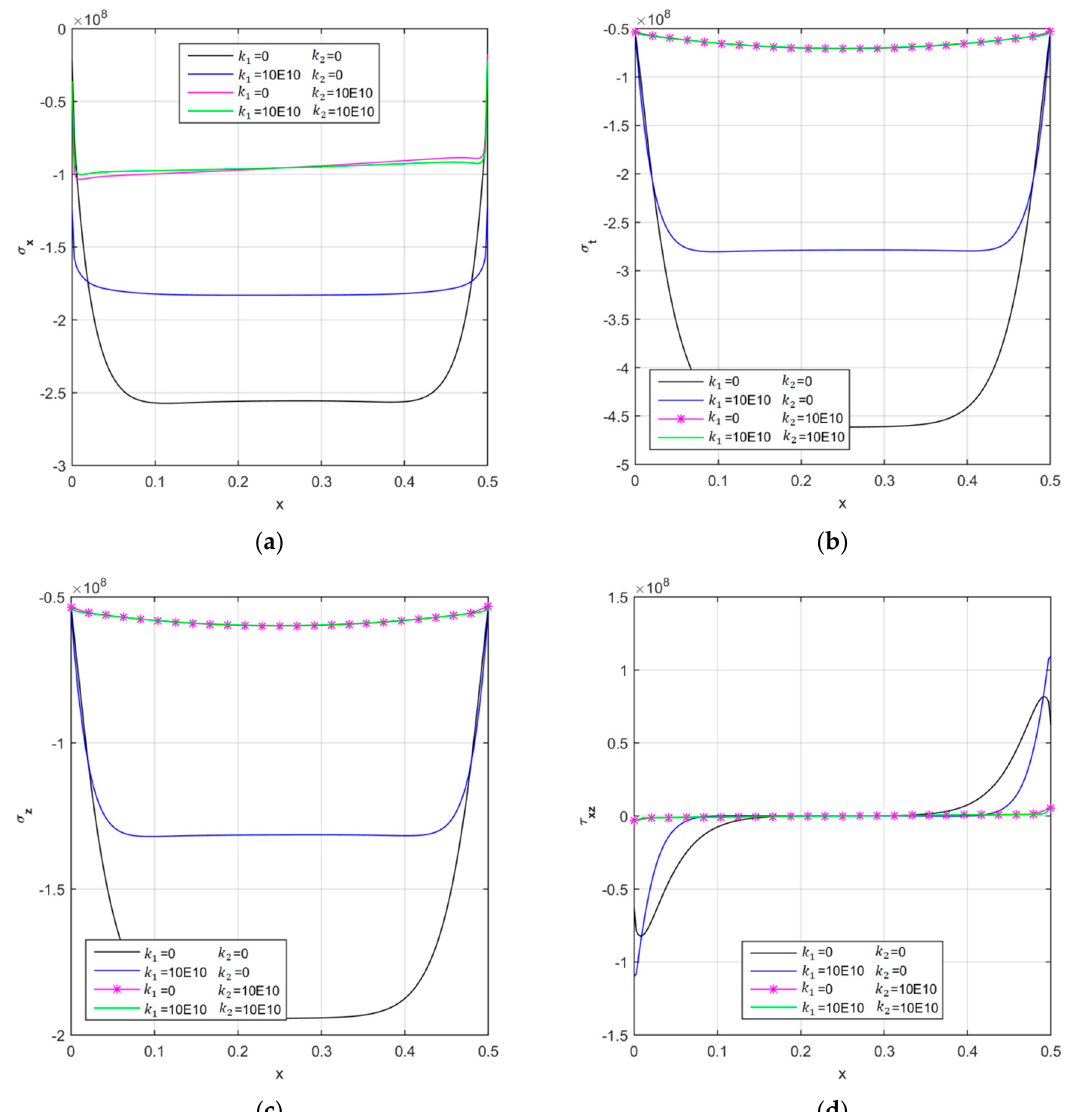
Figure 11. The longitudinal distribution of the axial ( a ), circumferential ( b ), radial ( c ), and shear ( d ) stress components [Pa] of the CNTRC cylinder for different Pasternak coefficients.